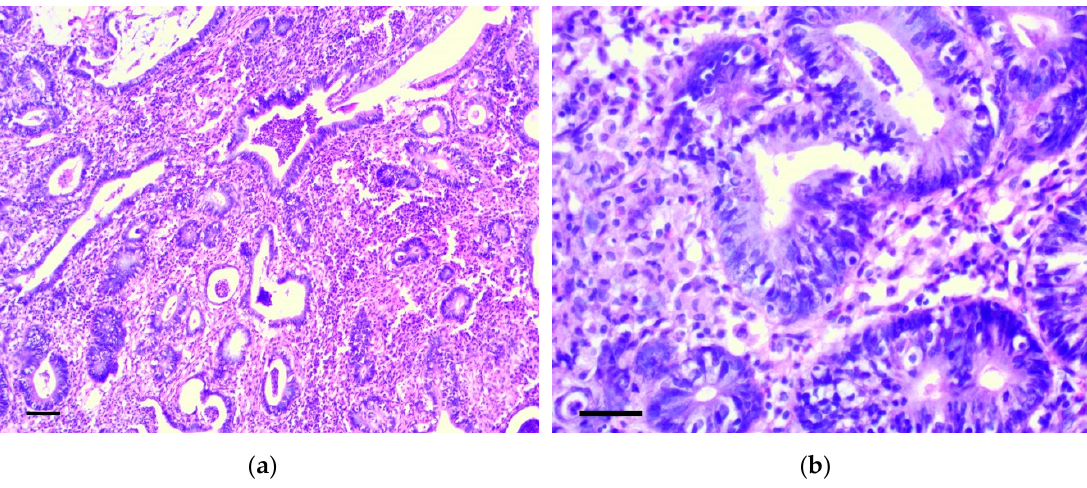
Figure 6. Well-differentiated adenocarcinoma of cecum. H&E staining: ( a ) 200×, scale bar 200 µm, ( b ) 800×, scale bar 100 µm.